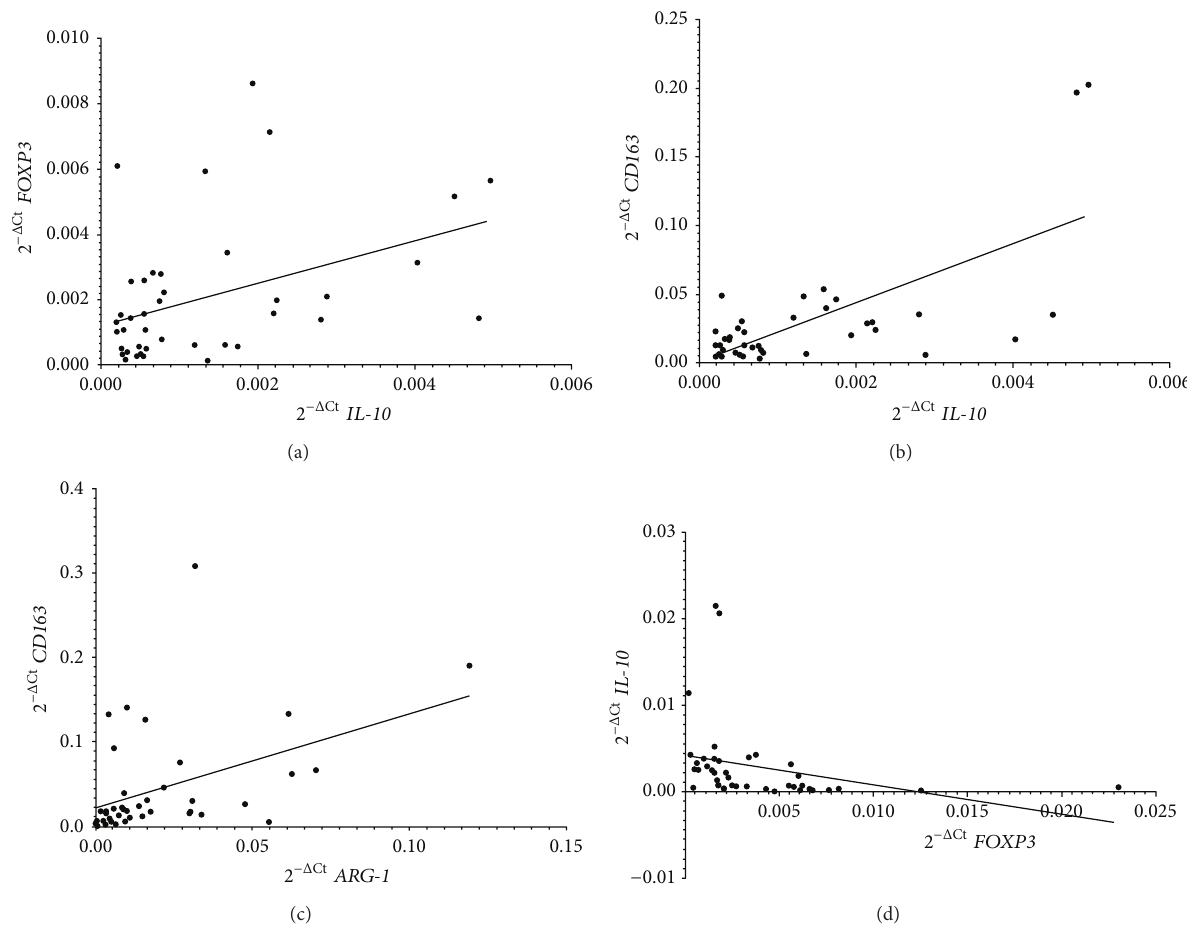
Figure 2: Correlations between IL-10 and FOXP3 (a) and IL-10 and CD163 mRNA (b), in BM samples, and ARG-1 and CD163 (c) and FOXP3 and IL-10 (d) mRNA in PB samples from 41 high-risk NB patients. Data are expressed as 2 −Δ Ct